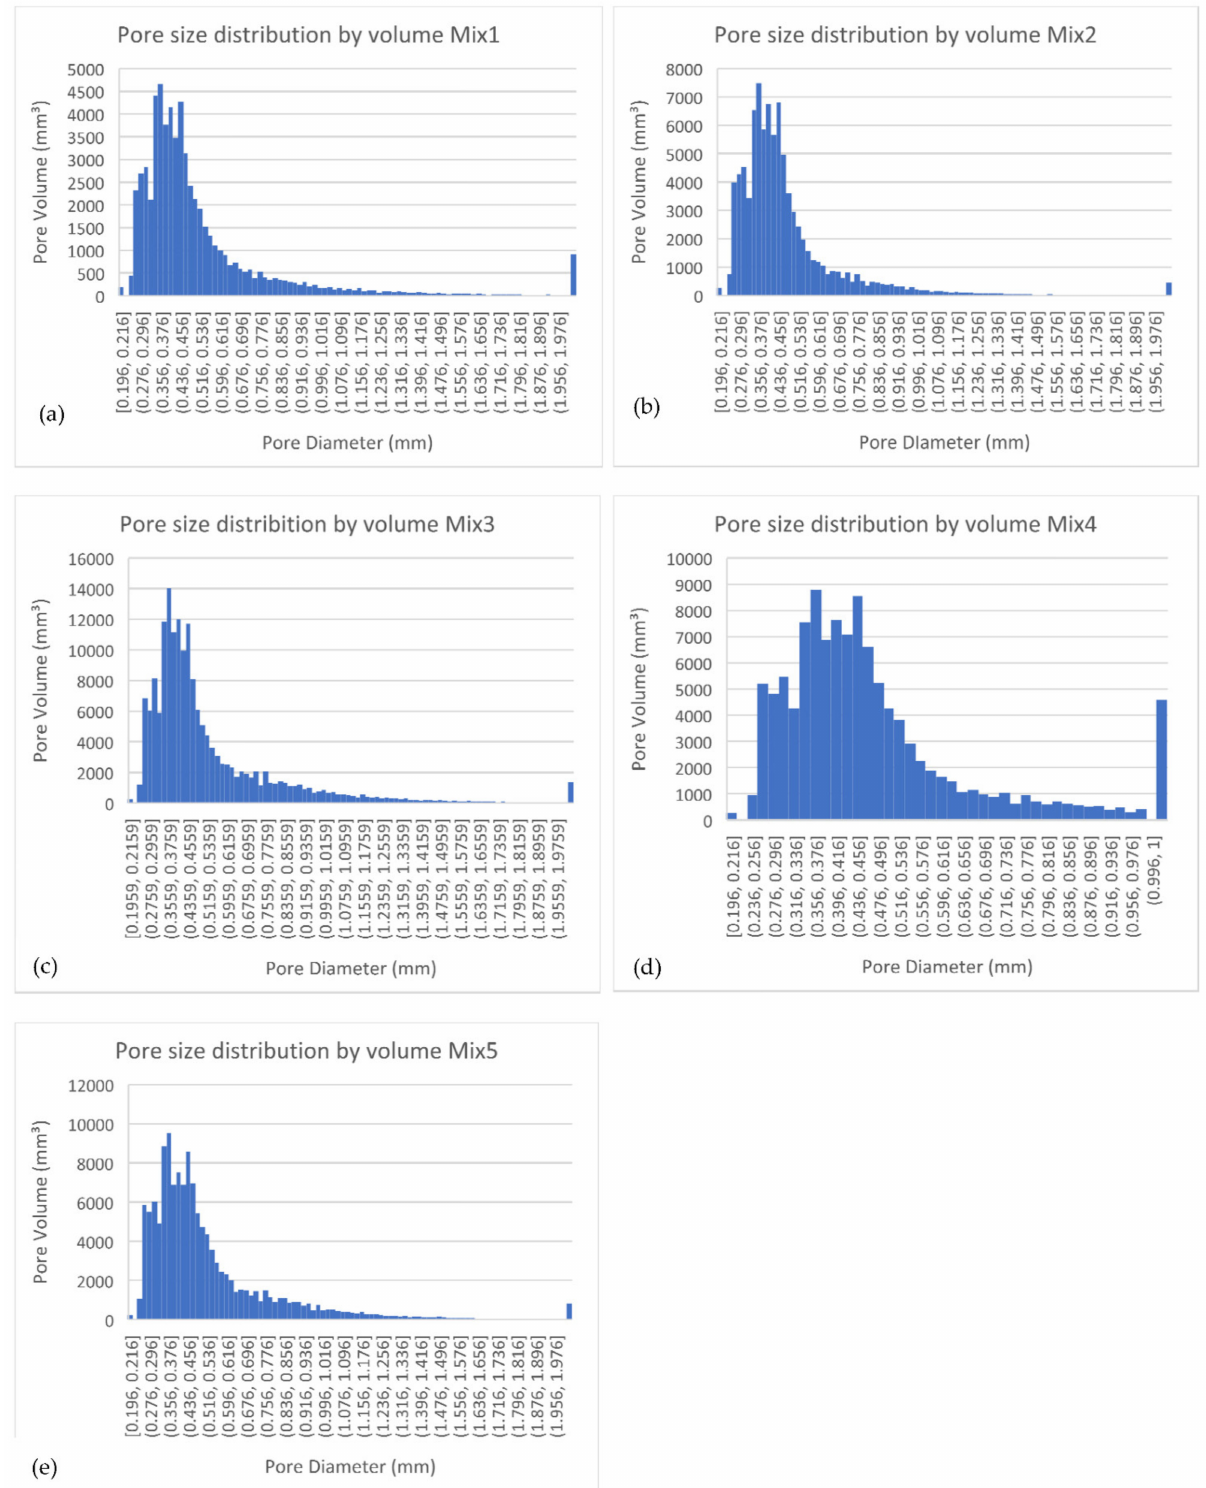
Figure 11. Pore size distribution by volume of ( a ) Mix 1 ( b ) Mix 2 ( c ) Mix 3 ( d ) Mix 4 and ( e ) Mix 5. When comparing the mechanical strength results to porosity, it is noted that Mixes 3 and 5 achieved the lowest strengths and the highest porosity. Porosity is one of the major determining factors for strength in concrete; with the decreasing compressive